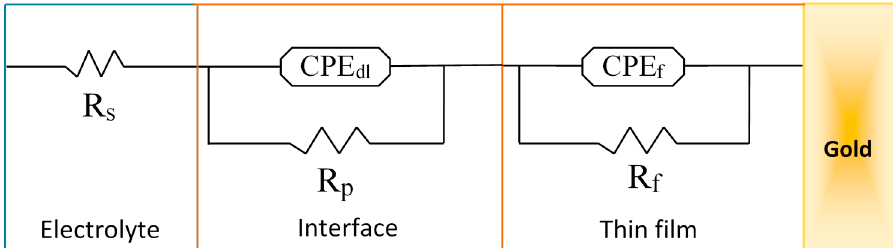
Figure 7. Equivalent circuit fitted to the impedance spectra, R s : resistance of the bulk electrolyte; CPE dl : constant phase element of the interface; R p : polarization resistance of the interface; CPE f : constant phase element of the film; R f : resistance of the film.